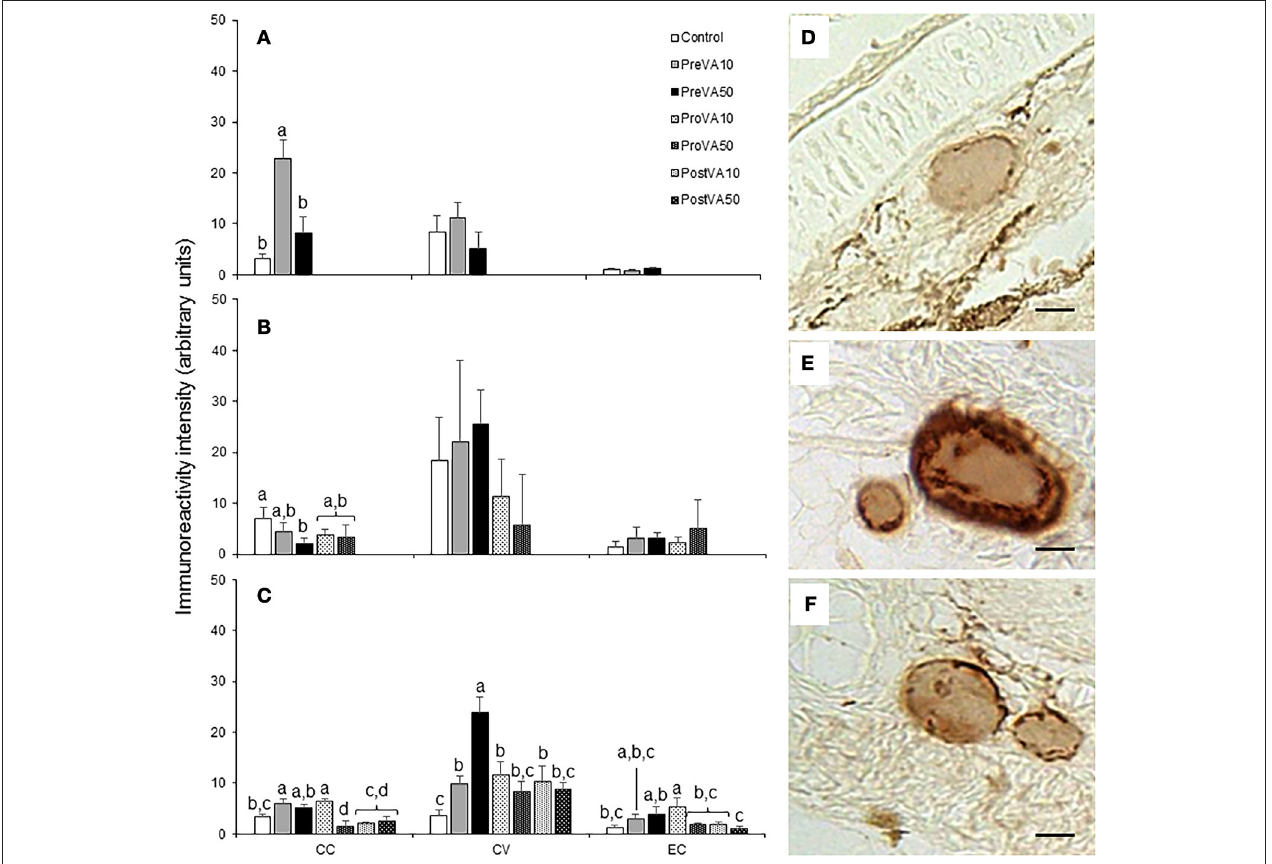
FIGURE 9 | Semi-quantitative assessment of thyroxine (T4) hormone (mean ± standard deviation) content by using immunohistochemical approaches in Senegalese sole fed with experimental diets. T4 content at 10 (A) , 21 (B) , and 55 (C) dph. A detailed view of the immunoreactive intensity in thyroid follicles in a Control (D) , PreVA10 (E) , and PreVA50 (F) larvae at 10 dph. CC , colloid content; CV , cortical vesicles content; EC , epithelial cells content. For a detailed description about the different experimental groups, please see the legend of Figure 1 . Different letters at the top of each bar denotes statistically significant differences among experimental groups (ANOVA, P < 0.05; N = 3). Scale bar = 200 µ